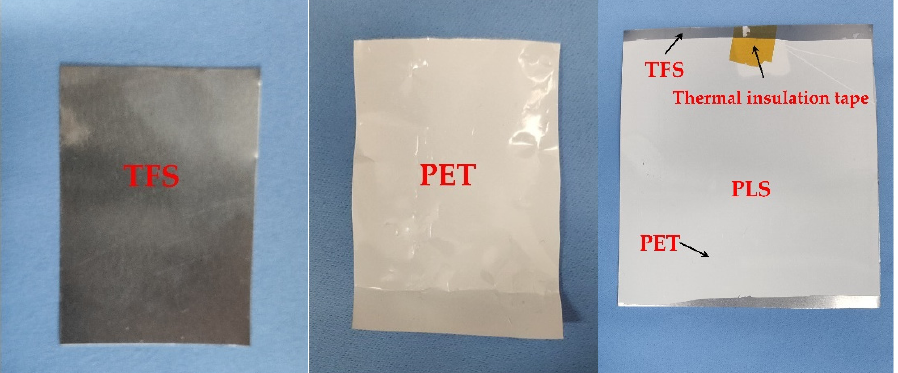
Polymers 2020 , 11 , x FOR PEER REVIEW Figure 2. Raw materials and polymer coated steel (PCS) samples Figure 2. Raw materials and polymer coated steel (PCS) samples.